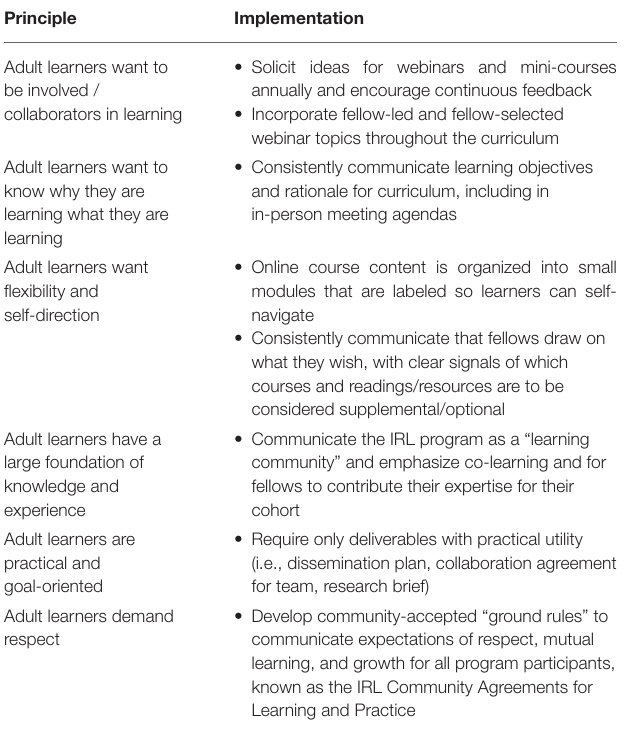
TABLE 2 | Adult learning principles incorporated into IRL program curriculum.